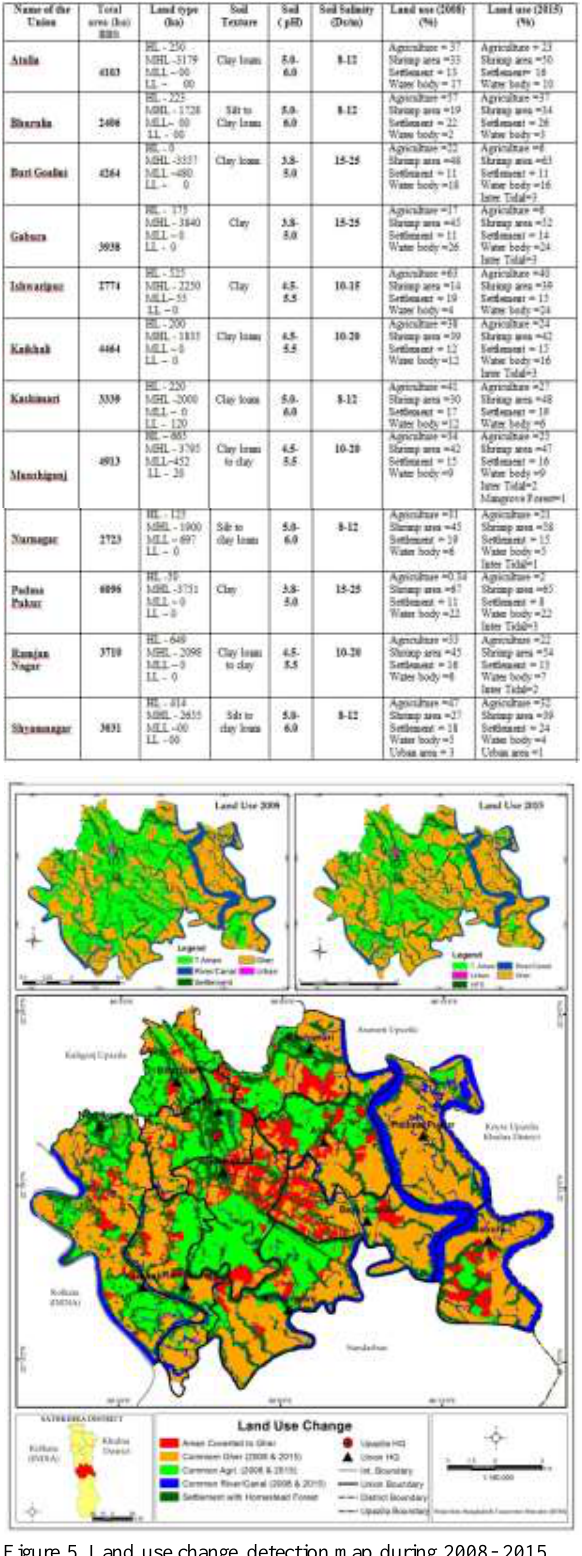
Figure 5. Land use change detection map during 2008-